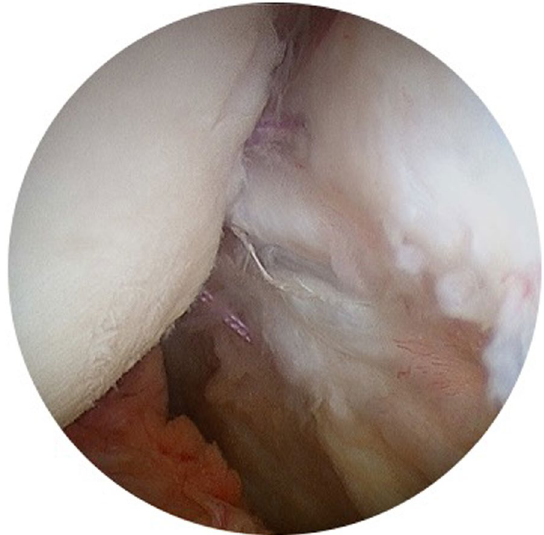
Fig. 1 The remplissage procedure. Sutures passed through the infraspinatus and the posterior shoulder capsule are tightened filling the humerus